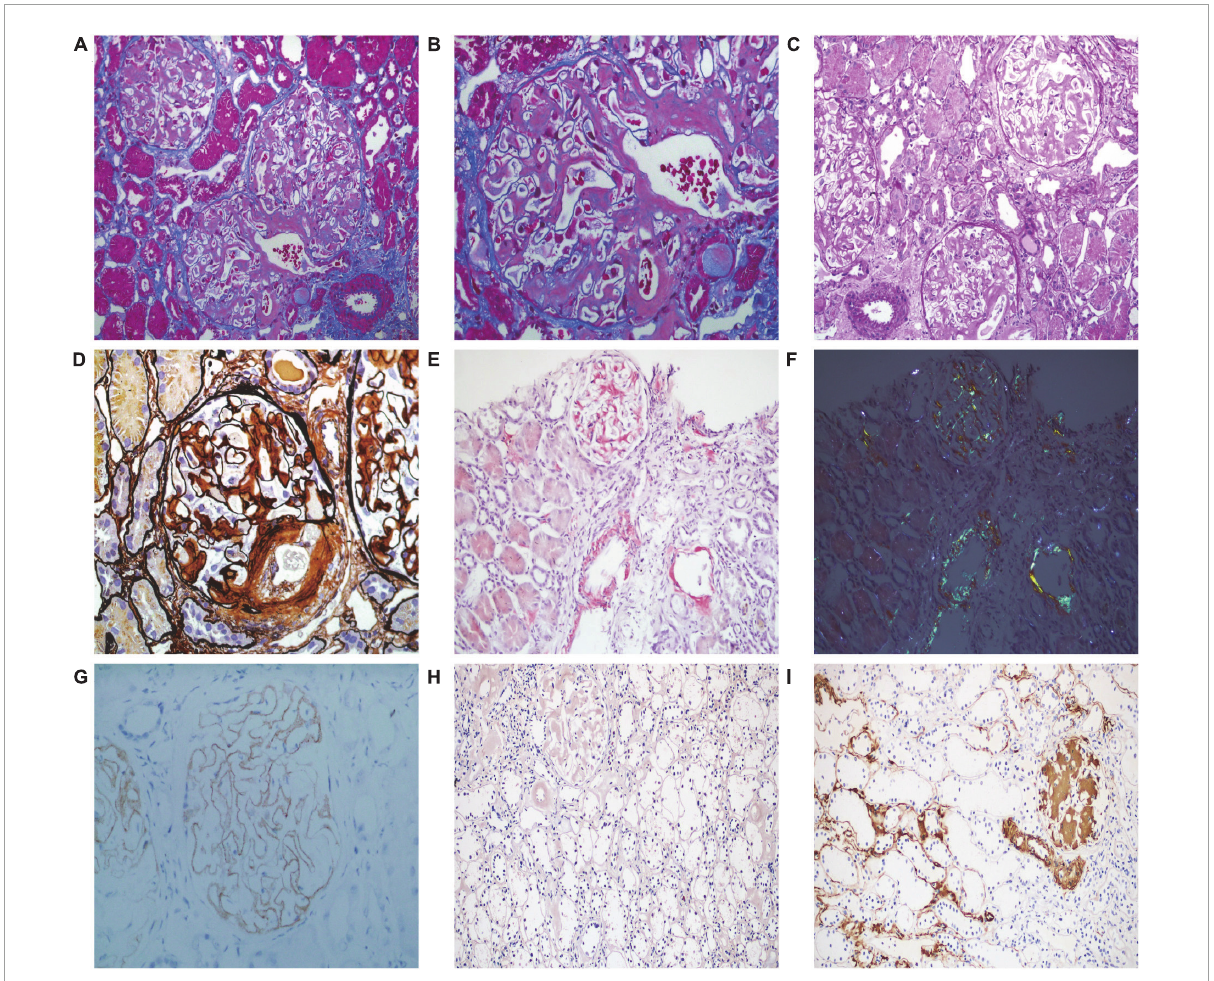
FIGURE1 Pathological features of light microscopy and immunohistochemistry. (A,B) Small amounts of erythrophilin were deposited under epithelial cells, and vacuolar degeneration of renal tubular epithelial cells (Masson staining, 200 × and 400 × , respectively). (C) Deposition of eosinophilic homogeneous unstructured material in the mesangial region, capillary wall, local interstitium, and some arteriolar walls (PAS staining, 200 × ). (D) Diffused mesangial broadening, with the basement membrane thickened segmentally, no absence of spike formation and no eyelash-like changes in the glomerular basement membrane (PASM staining, 400 × ). (E) Positive staining of Congo red of glomeruli, partial arteriole walls, and local interstitium (Congo red staining, 200 × ). (F) Pathological apple-green birefringence under cross-polarized light (200 × ). (G) Fine granular deposition of phospholipase A2 receptor along the capillary walls (immunohistochemistry, 400 × ). (H) Amyloid-associated protein was negative in the mesangial area of the glomeruli and arteriolar wall, as well as in the focal renal interstitium (immunohistochemistry, 200 ×